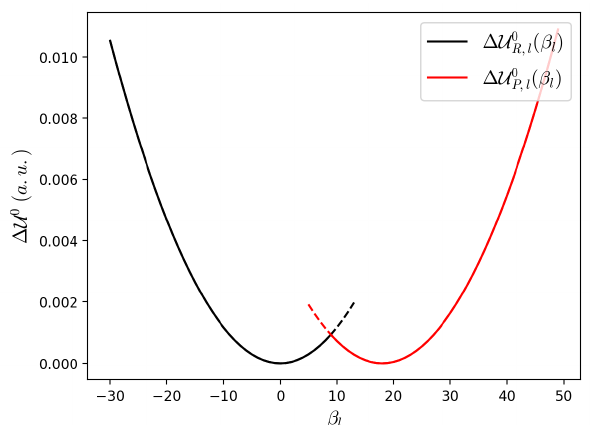
Figure 2. R and P unperturbed harmonic energies. After the intersection ∆ U 0 a black dashed line and before the intersection ∆ U 0